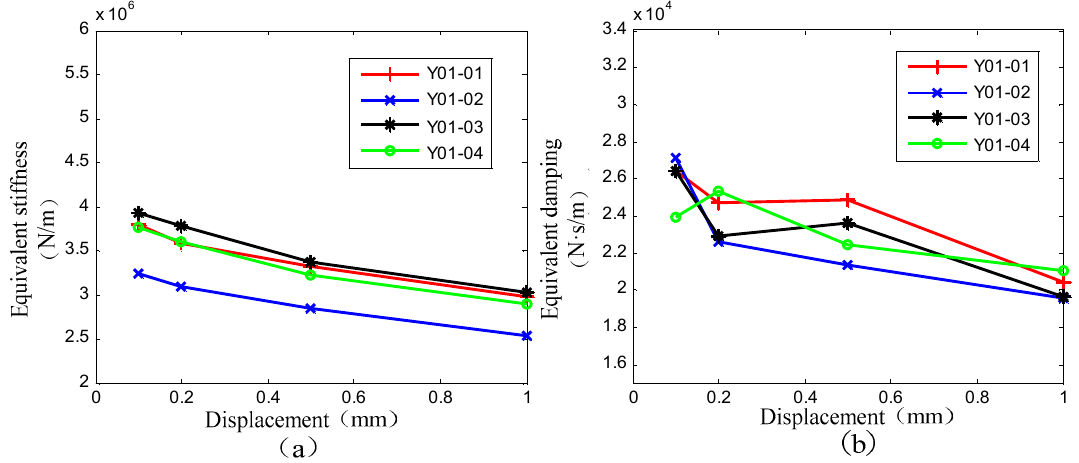
Figure 14. Dynamic parameters of specimens Y01-01~04 vary with displacement at 5 Hz: ( a ) equivalent stiffness and ( b ) equivalent damping.